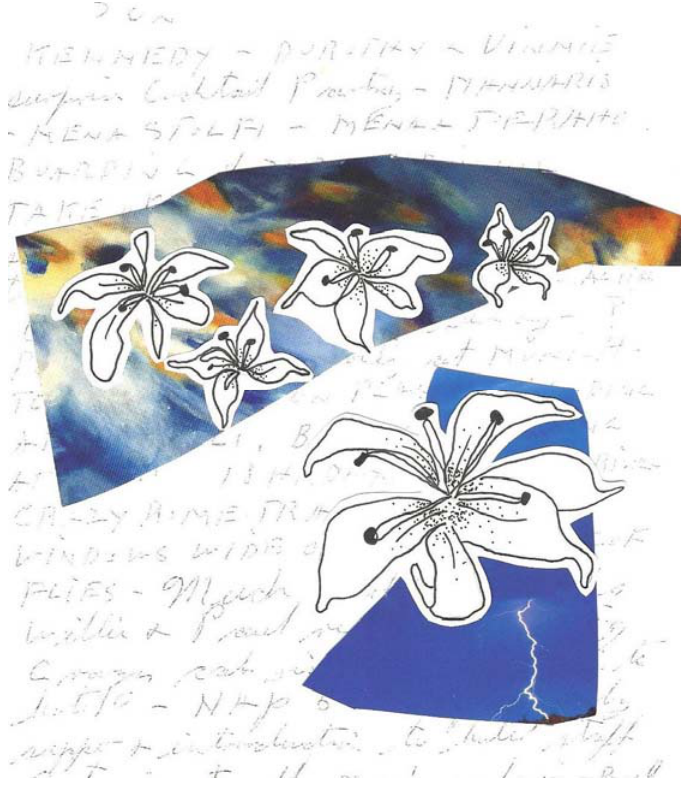
Figure 5. Drawing and collage, with letter written by Peter